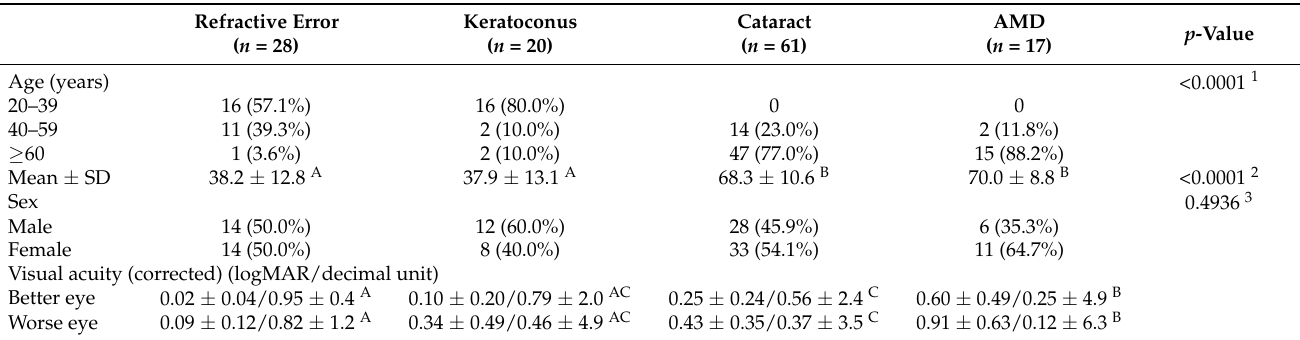
Table 1. Demographic characteristics among four study groups with different ocular disorders ( n = 126).